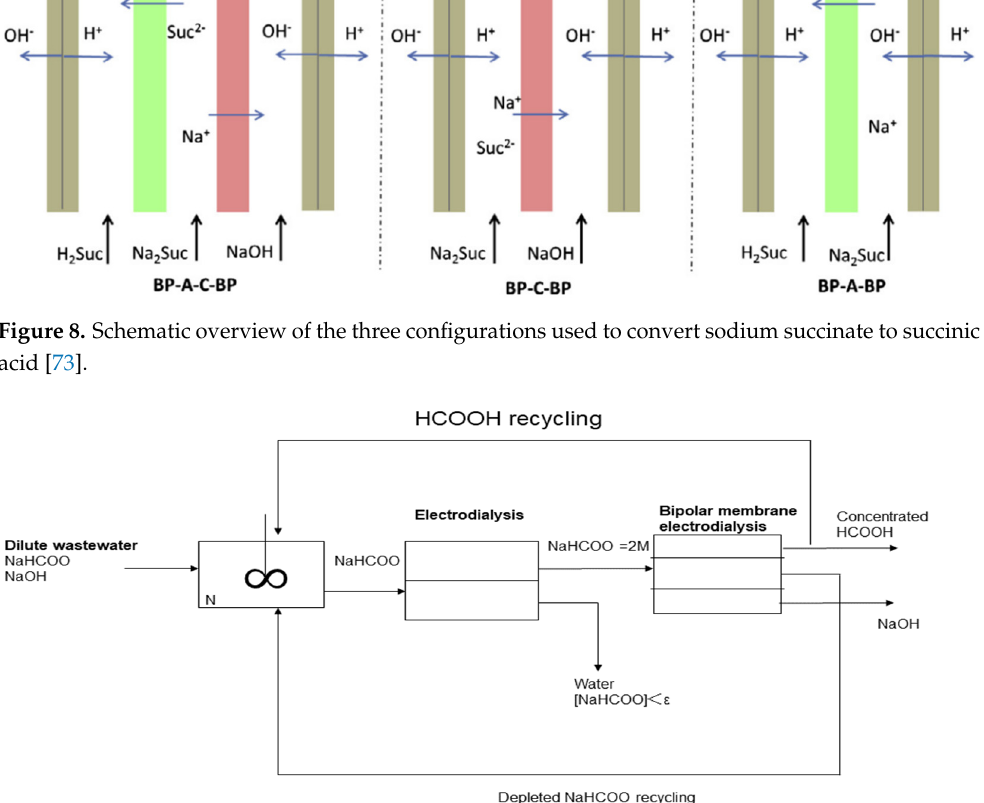
Figure 10. Scheme of the membrane module in the BMED and the predominant transport mecha- nisms during the separation, C 1 : NaOH compartment; D 2 : itaconic acid compartment; C 2 : itaconic acid sodium compartment [77]. The integration of BMED with other processes is also used to recover organic acids and bases. Prochaska et al. [55] proposed a new method (Figure 11) based on nanofiltra- tion, BMED, and reactive extraction techniques for the recovery of fumaric acid from a fermentation broth of glycerol biotransformation, and 95% of fumarate can be concen- trated and converted to fumaric acid.